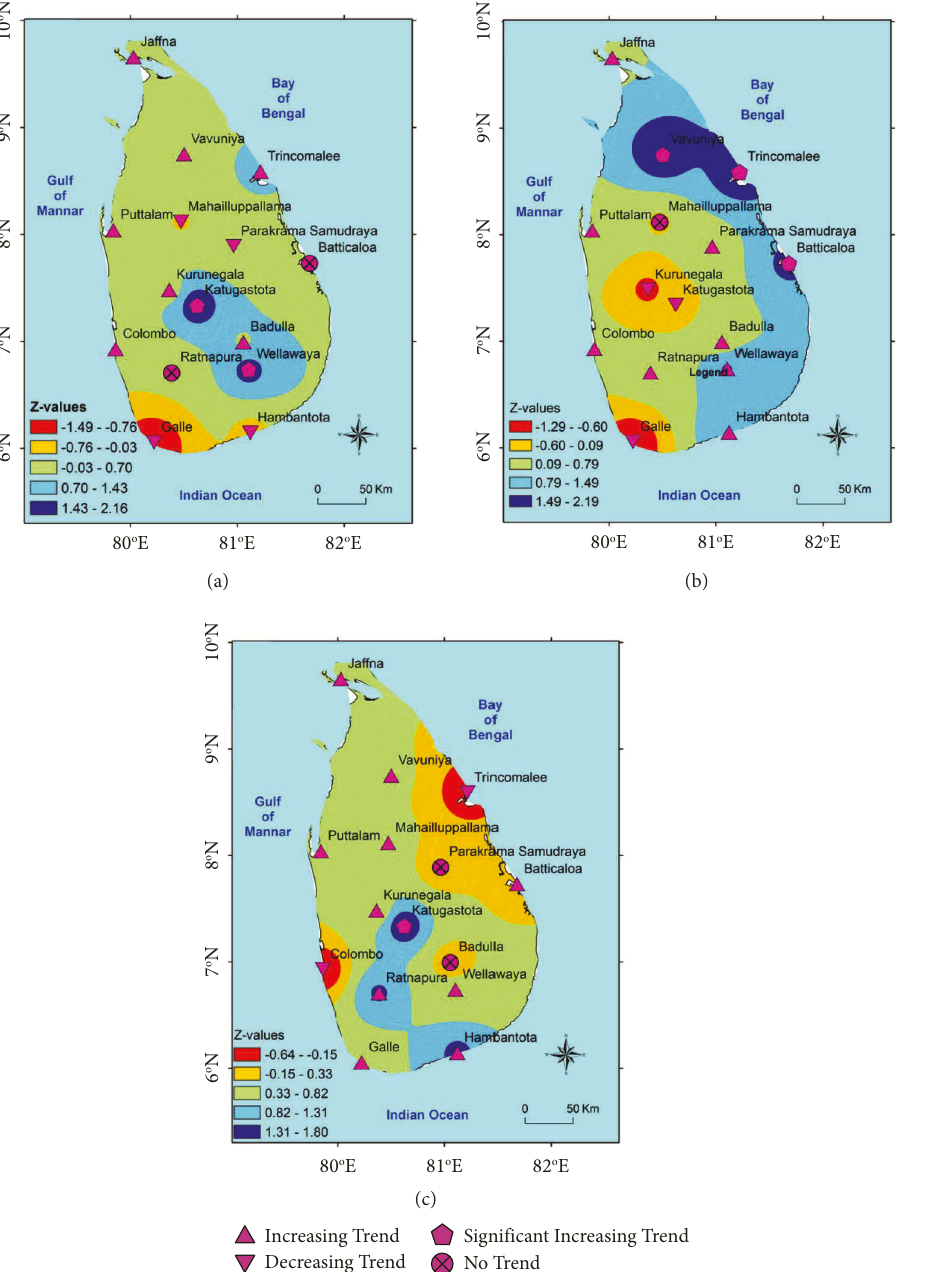
Figure 6: Spatial trend of mean annual and seasonal PCI in Sri Lanka. (a) For annual PCI trends. (b) For SWM PCI trends. (c) For NEM PCI